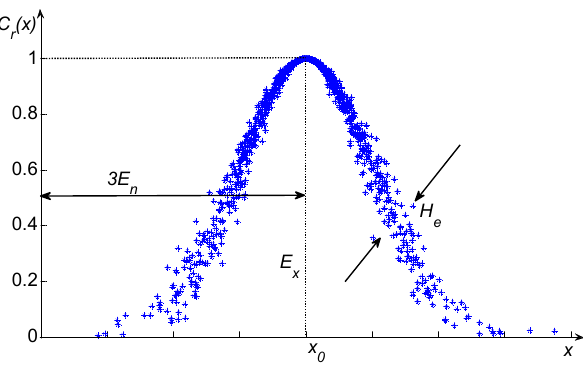
Figure 3. Three digital characteristics of a fuzzy set.